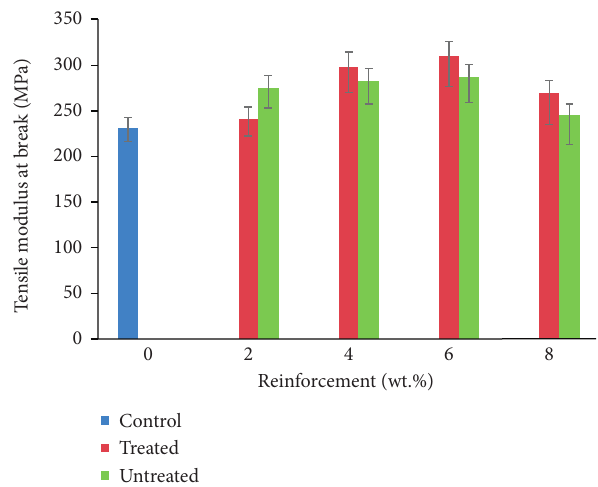
Figure 4: Variation in tensile modulus of coir fibre and yam peel particulate polyethylene